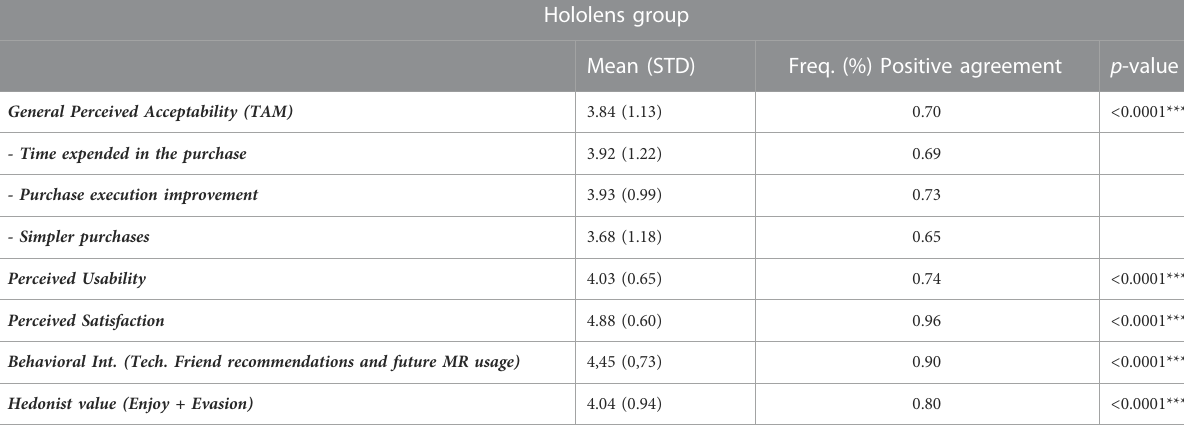
TABLE 6 Mean and frequency of rating scores.